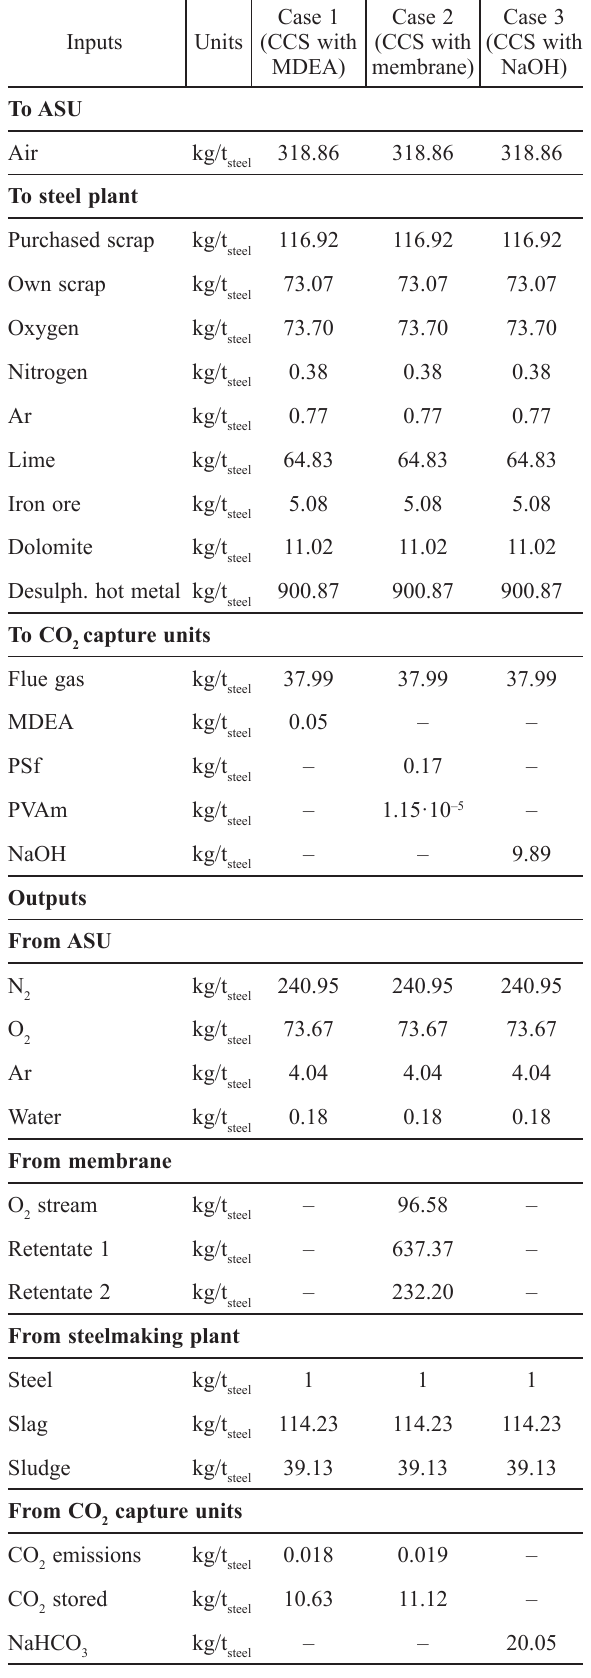
Table 5 – LCI for Cases 1 – 3 for the production of 1 ton of steel